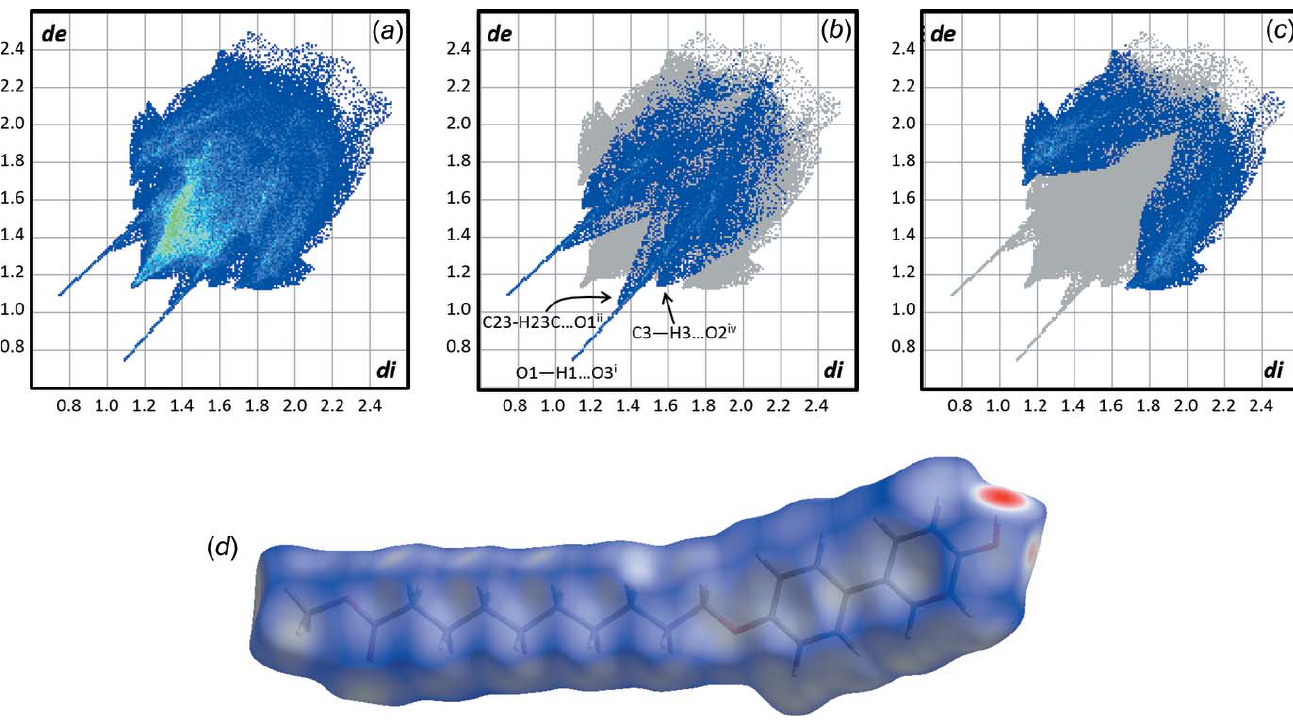
Figure 4 Fingerprint plots for MBO10Me , including ( a ) all intermolecular contacts, ( b ) H (cid:2)(cid:2)(cid:2) O interactions, ( c ) C—H (cid:2)(cid:2)(cid:2) (cid:2) interactions, and ( d ) Hirshfeld surface for MBO10Me .